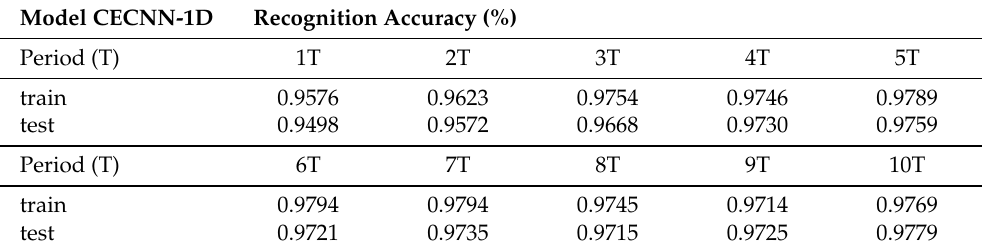
Table 5. Experimental results under different timing widths of CECNN-1D model.